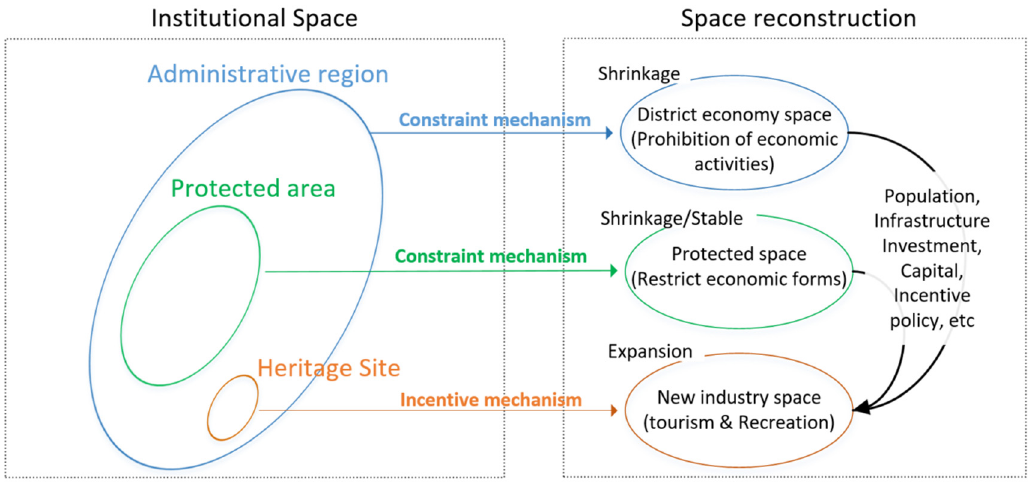
Figure 6. Spatial reconstruction under the guidance of institutional space.